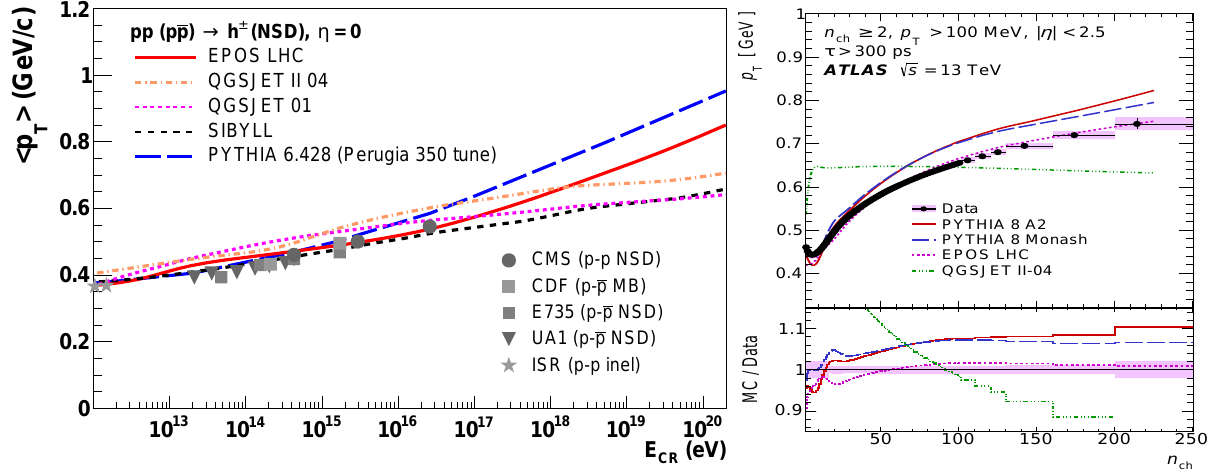
(cid:68) (cid:69) p at midrapidity as a function of primary CR energy [31]. Right: Data–model comparison T